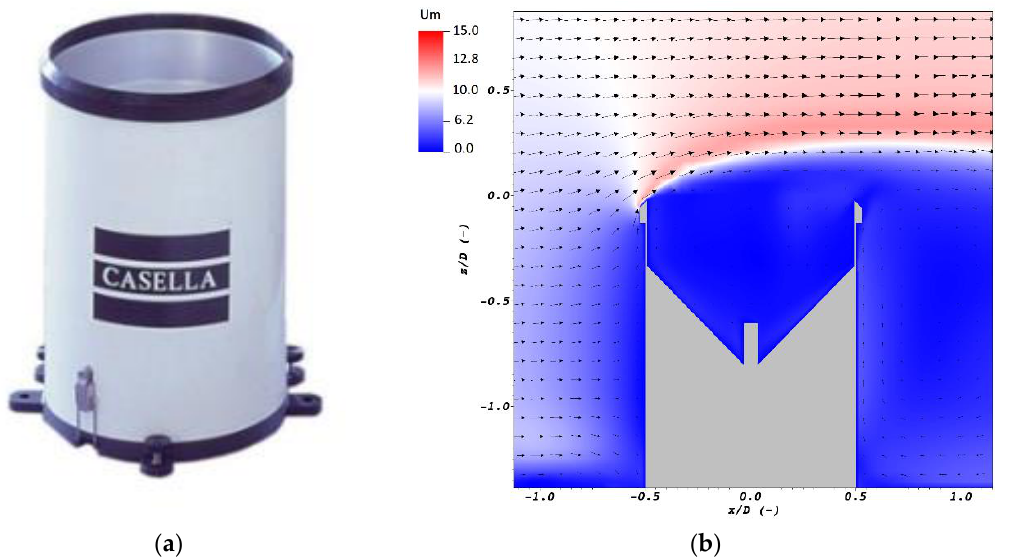
Figure 1. ( a ) The Casella tipping-bucket rain gauge; ( b ) a sample section of the airflow field (velocity magnitude, U m (m s -1 )) along the stream-wise vertical symmetry axis of the gauge at wind speed of 10 m s −1 (from CFD simulations by [13]).